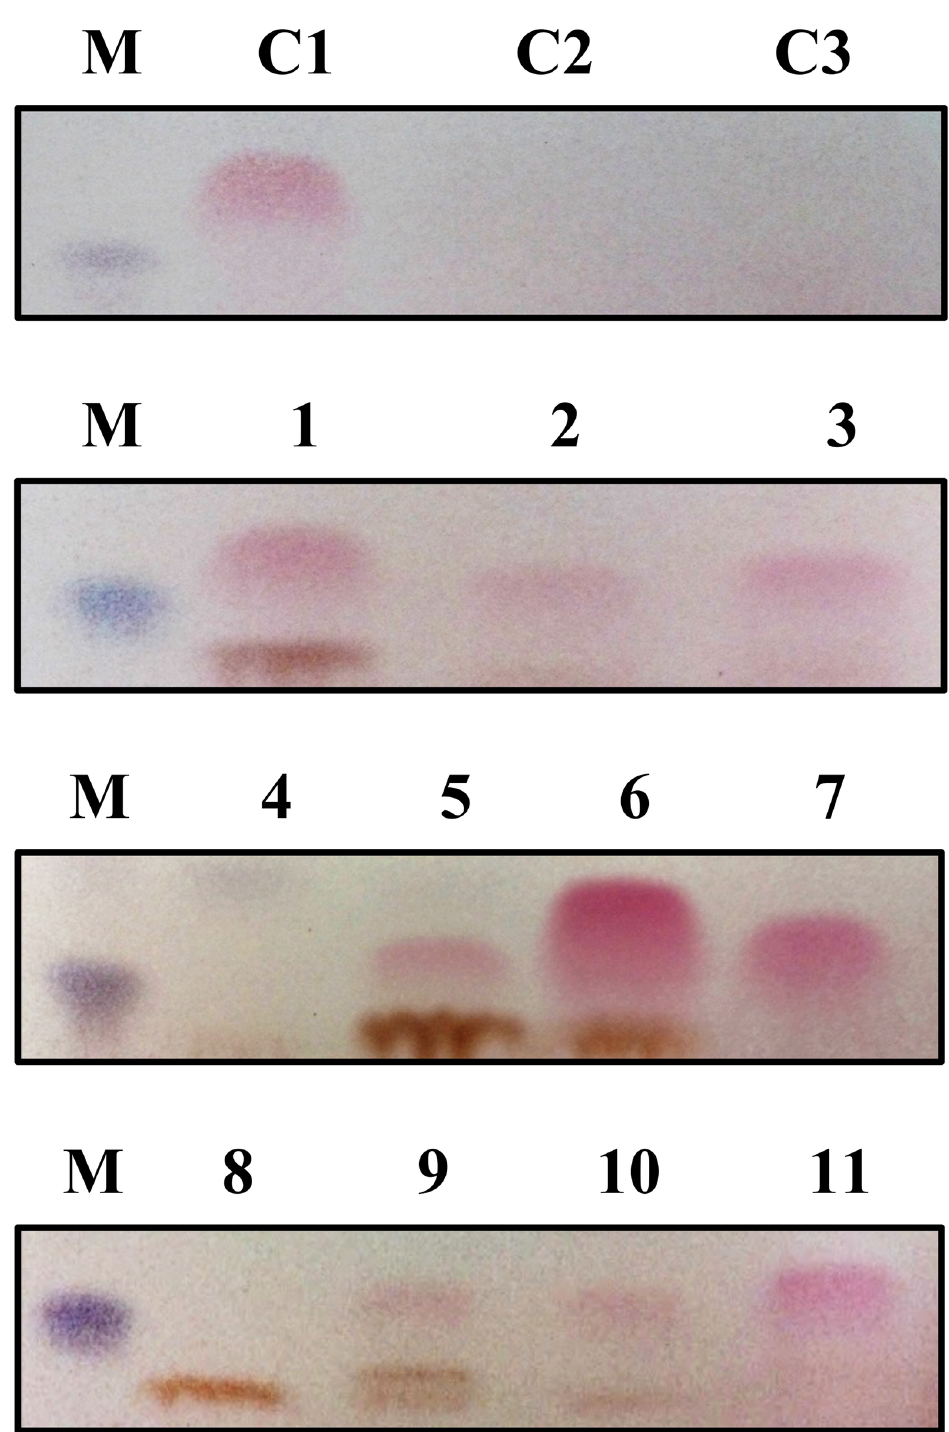
Fig 1. Thin-layer chromatography (TLC) of alginate degraded products using the bacterial strains isolated in this work. The region indicating the presence of alginate monosaccharides are shown since the presence of monomeric sugars indicates the ability of the strains to degrade alginate. M: Hydrolyzed sodium alginate, C1: Saccharophagus degradans , C2: Commercial sodium alginate, C3: Marine broth, 1: ADB-BSW-1, 2: ADB-BSW-2, 3: ADB-BSW-3, 4: ADB-BSW-4, 5: ADB-BSW-5, 6: ADB-BSW-6, 7: ADB-BSW-7, 8: ADB-BSW-8, 9: ADB-BSW-9, 10: ADB-BSW-10, 11: ADB-BSW-11. Full TLC images of the degraded products by each strain are provided in S1 Fig in the Supporting Information section for further reference.